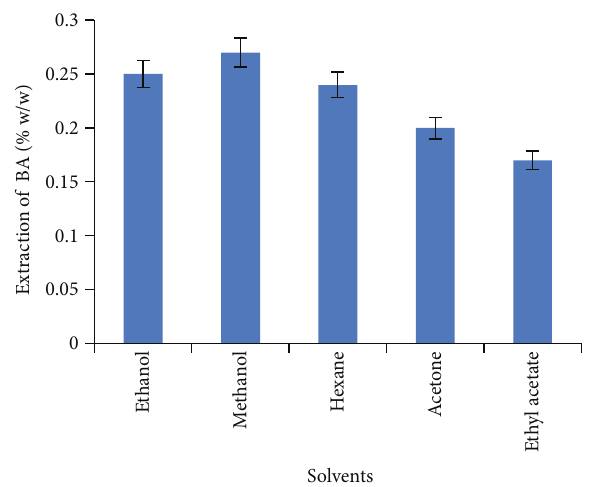
Figure 7: The effect of stirring extraction with various solvents at 70 ∘ C for 160min.